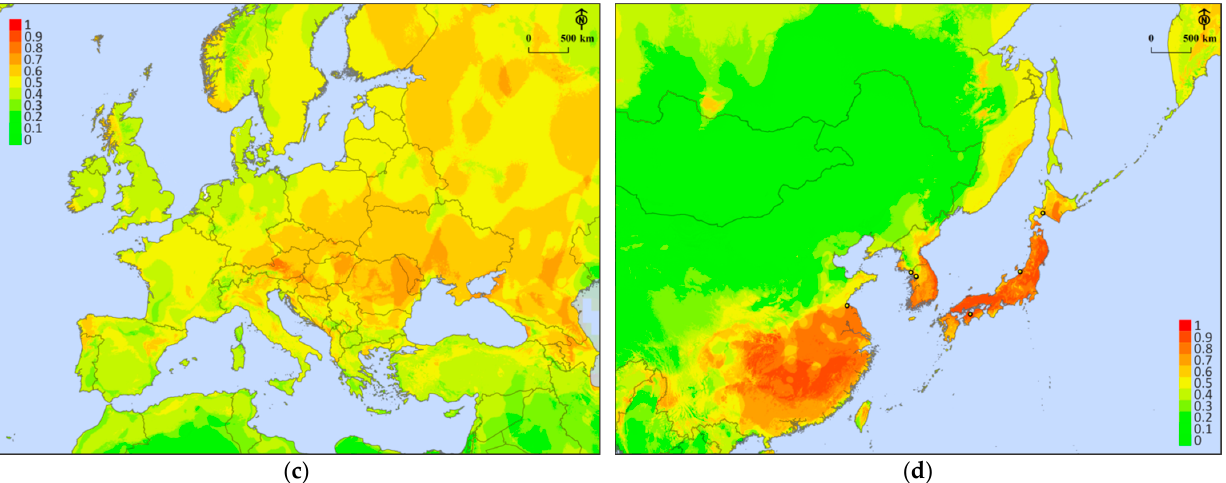
Figure 3. Future climate scenarios modeled for the year 2050 and confirmed current occurrences: ( a ) Phyllactinia fraxini in Europe, ( b ) P. fraxini in Southeast Asia, ( c ) P. fraxinicola in Europe, and ( d ) P. fraxinicola in Southeast Asia. The horizontal scale bar refers to the probability of distribution (1, high habitat suitability; 0, not suitable).